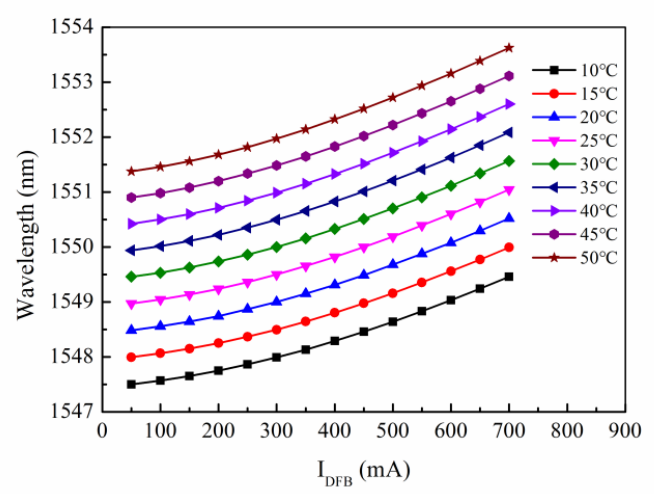
Figure 5. Measured lasing wavelength under different values of I DFB at different temperatures.